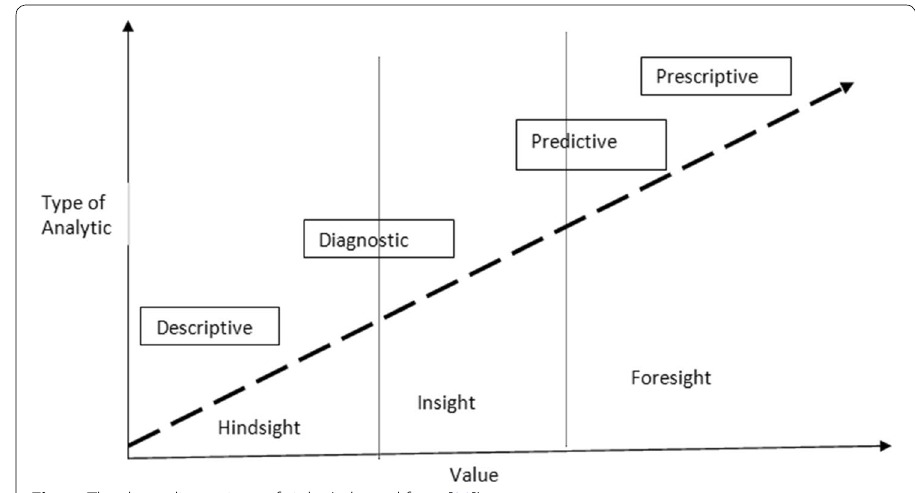
Fig. 4 The three dimensions of sight (adapted from